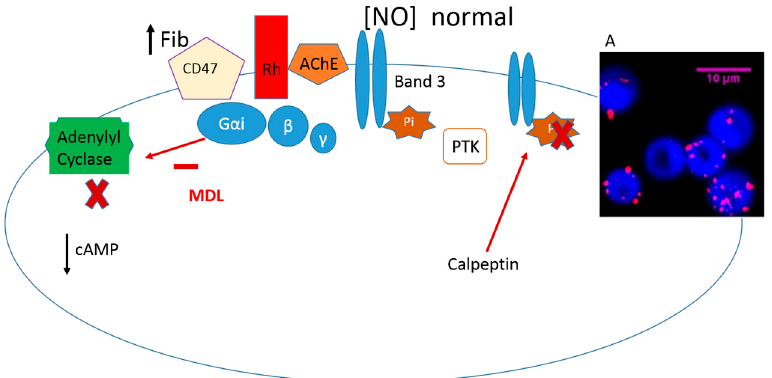
Figure 3. Schematic representation of the soluble fibrinogen transduction pathway of NO efflux from human erythrocytes supported by in vitro studies of hyperfibrinogenemia model under the presence of calpeptin inhibitor of PTP [70–73]. A: The soluble fibrinogen binding to erythrocyte membrane (blue color) CD47 (red color) [73].